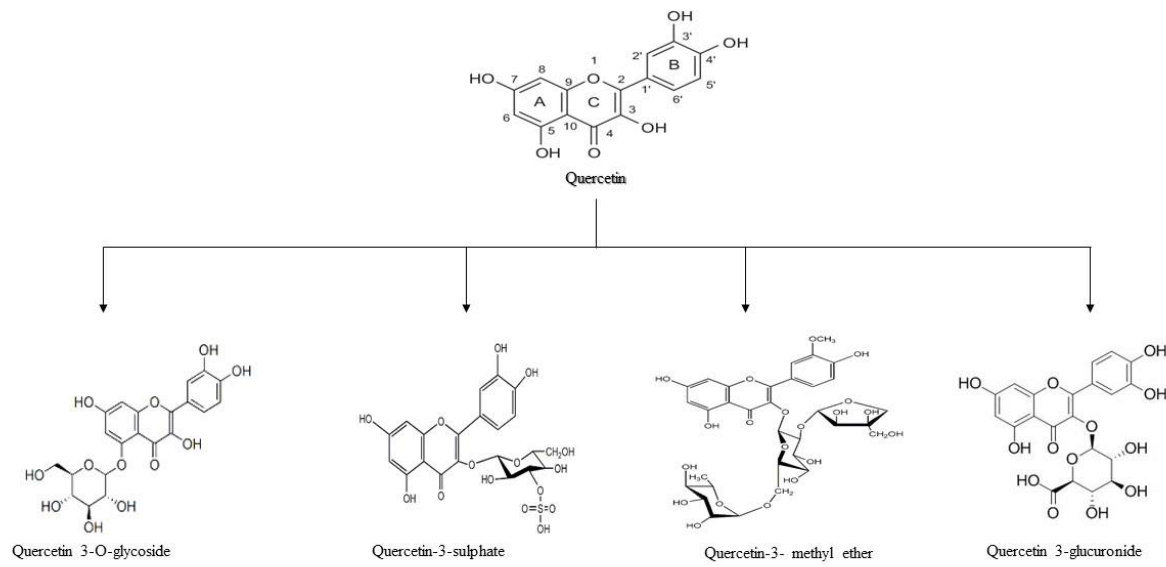
Figure 1. Structure and major classes of quercetin.